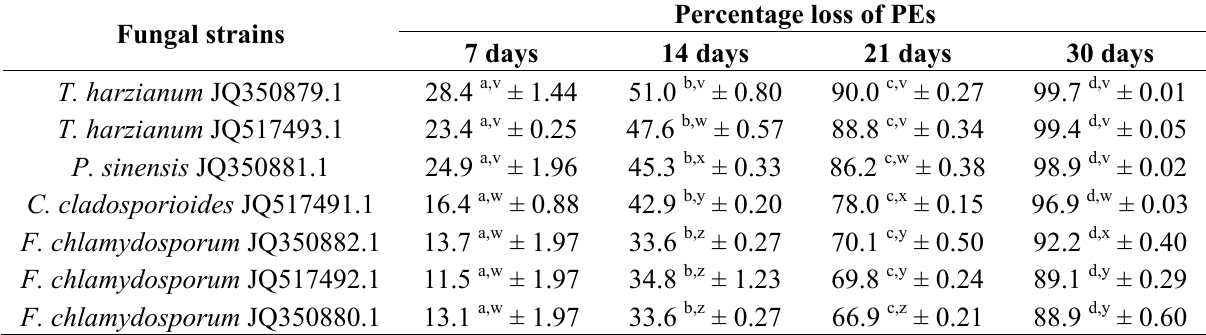
Table 1. Percentage degradation of phorbol esters (PEs) by fungal strains in potato dextrose broth (PDB) medium at different incubation